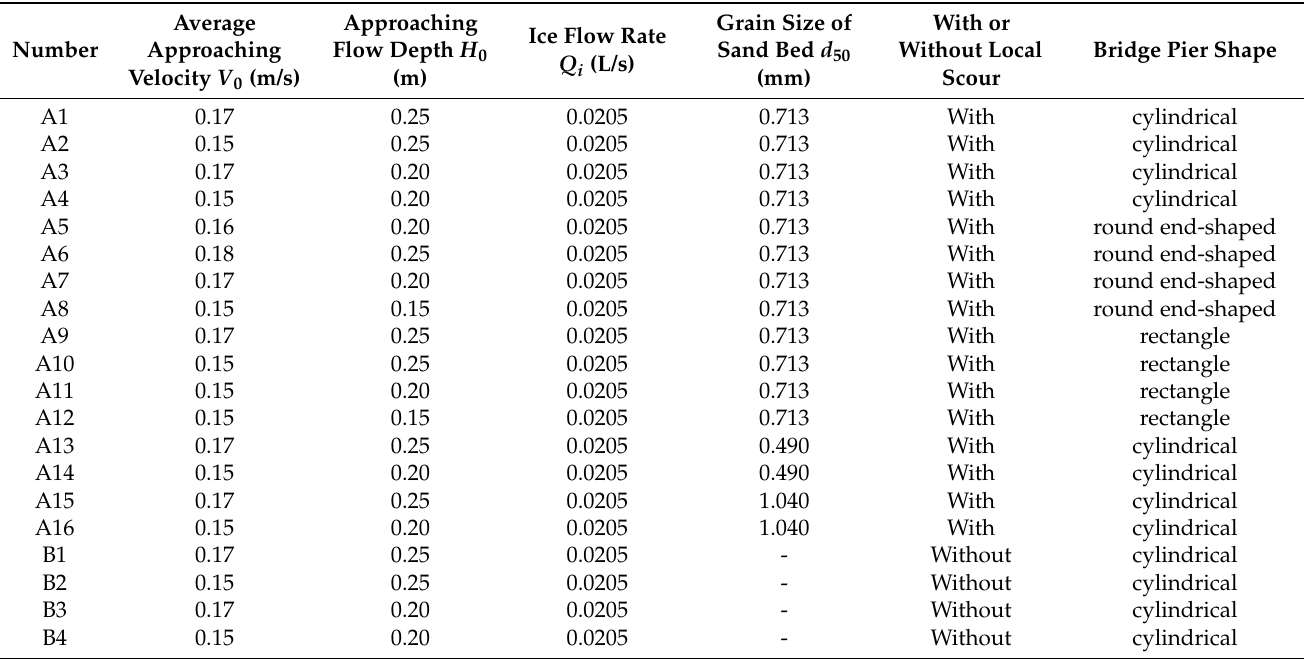
Table 1. Summary of all experimental runs.